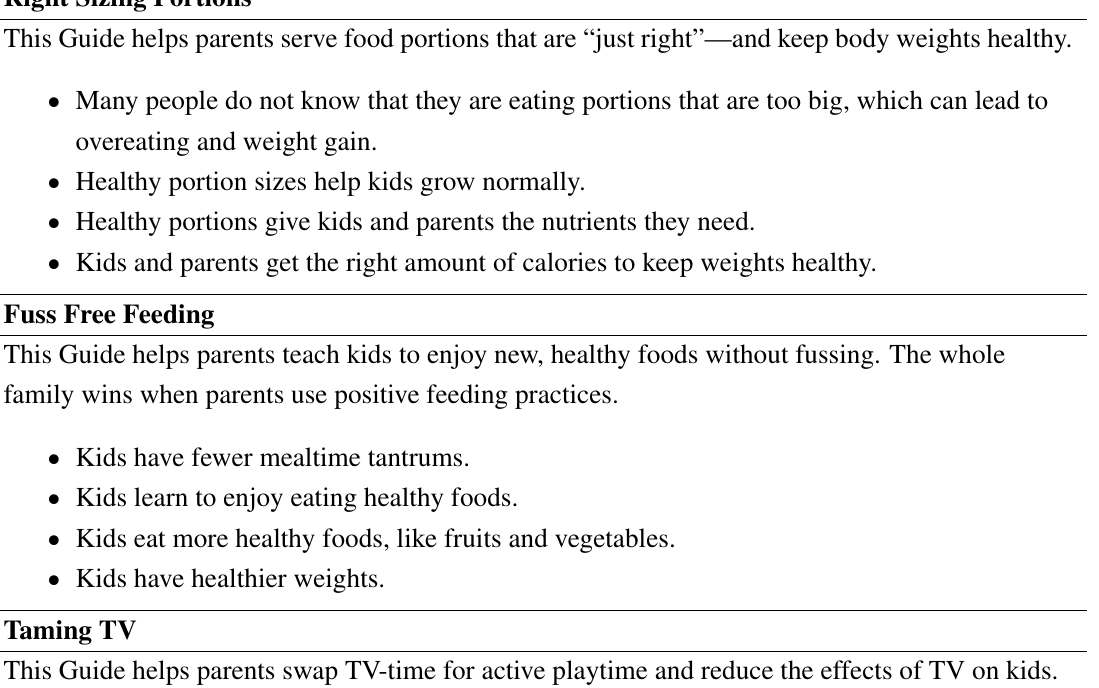
Table 1. Cont . Description and Main